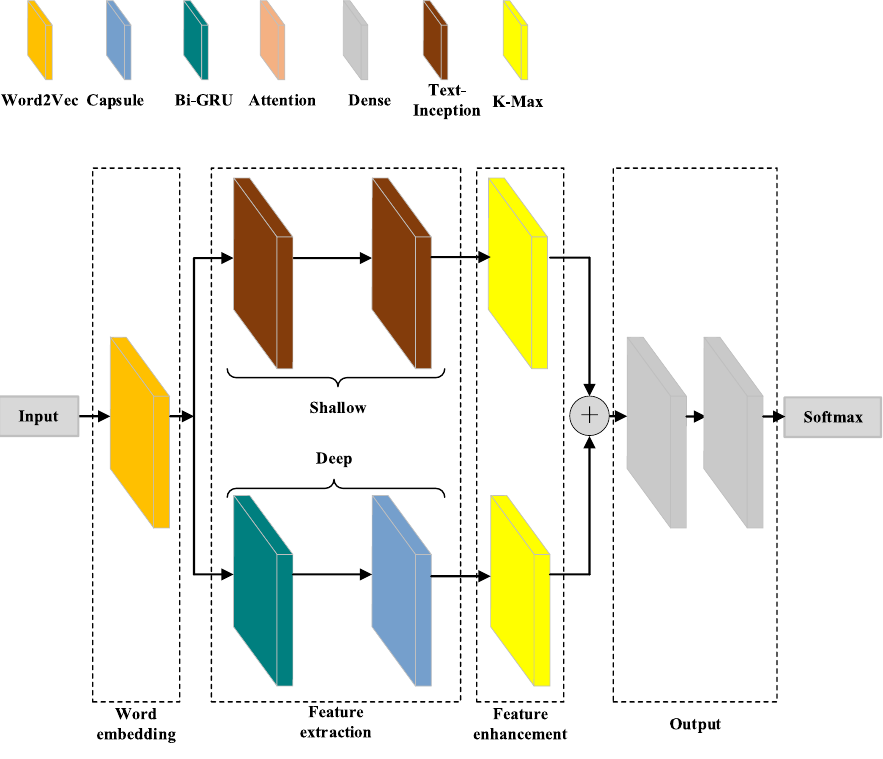
Figure 1. The overall framework of the feature-enhanced Text-Inception model for Chinese long text classification.